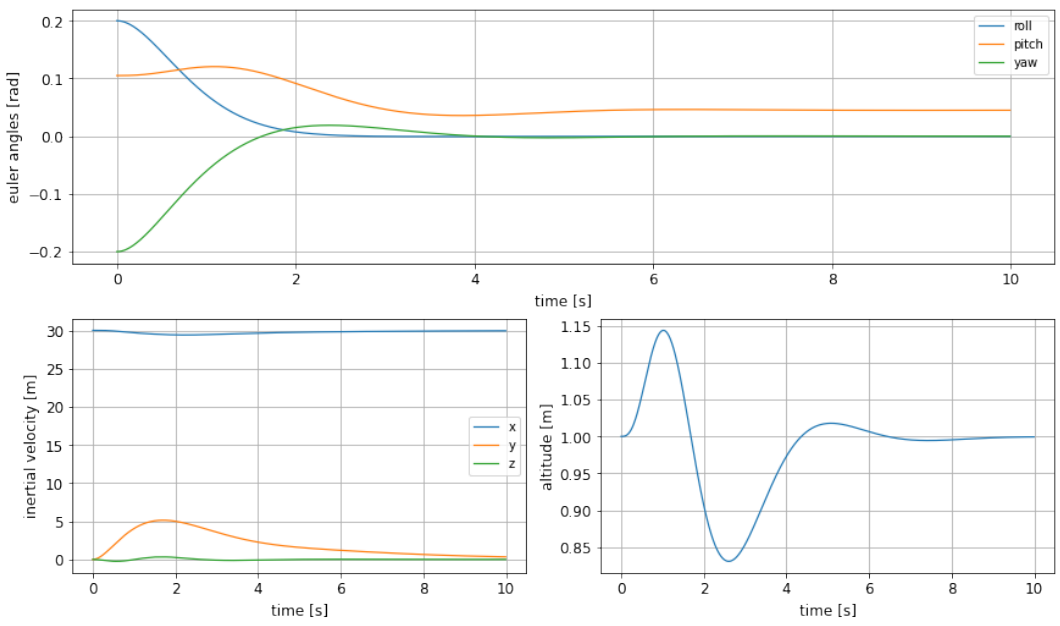
Figure 13. LQR controller for recovery from disturbed attitude.